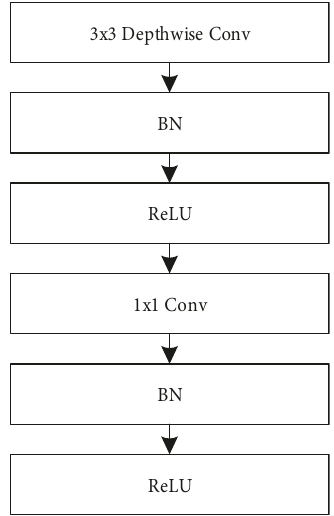
Figure 1: Depthwise separable convolution structure.